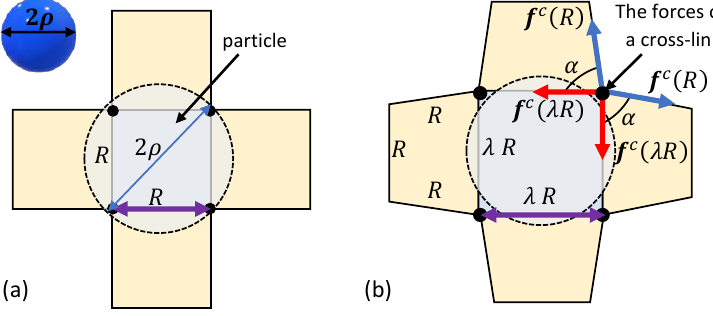
Figure 3. The penetration of a spherical particle into a network with a locally quadrilateral lattice. ( a ) The relaxed state and ( b ) the deformed configuration due to the sink of the particle.